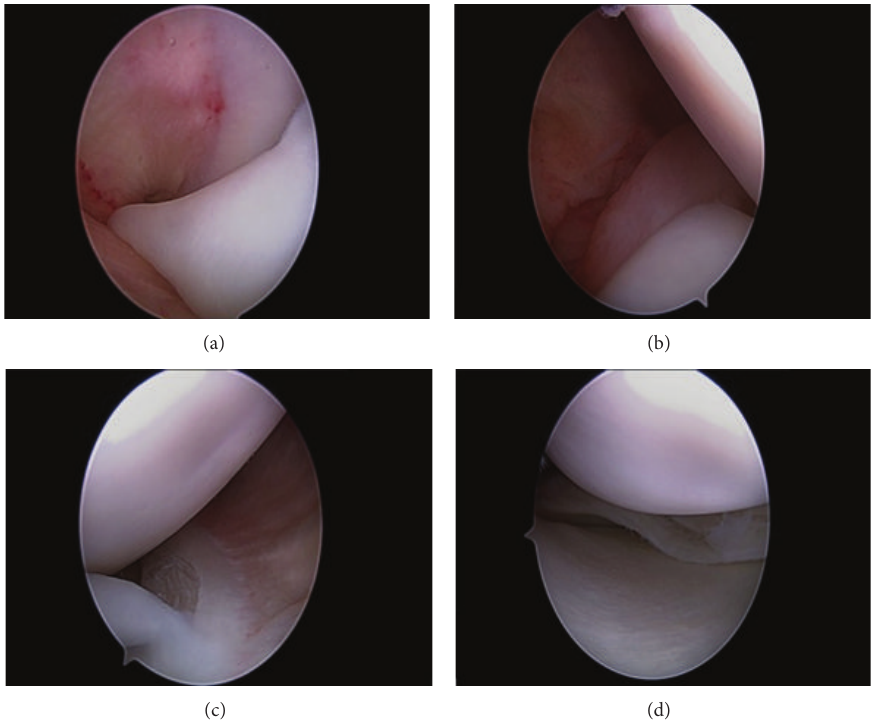
Figure 4: (a) Large displaced medial meniscus fragment located in the intercondylar notch. (b) Posterior edge of the tear. (c) Anterior edge of the tear. (d) Medial meniscus remaining after